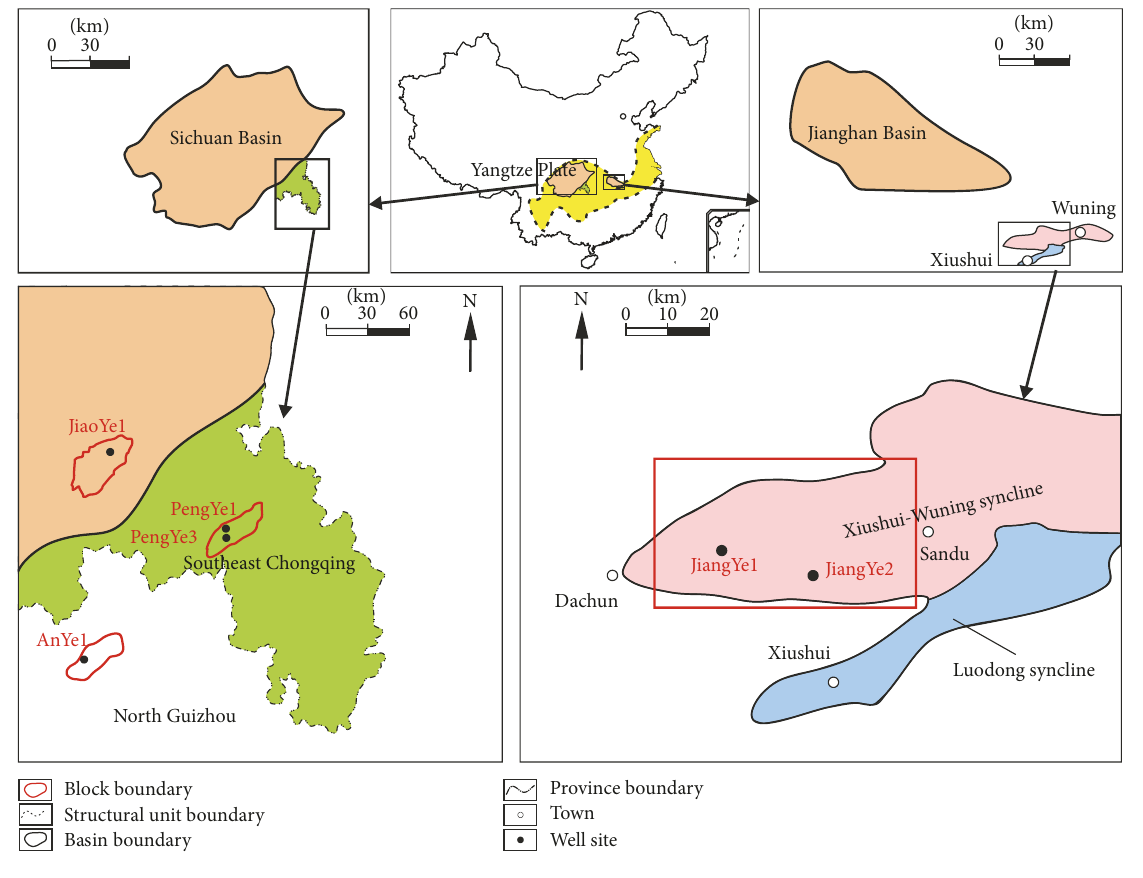
Figure 1: Geological map of Jiaoshiba, Anchang, Pengshui, and Xiuwu Basin with well locations.